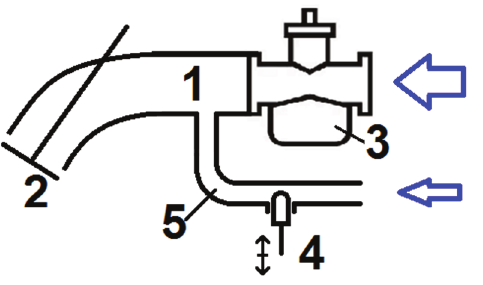
Fig. 9. Scheme of a modification of the air intake system: 1– intake port, 2 – intake valve, 3 – carburetor, 4 – additional-air valve, 5 – additional-air